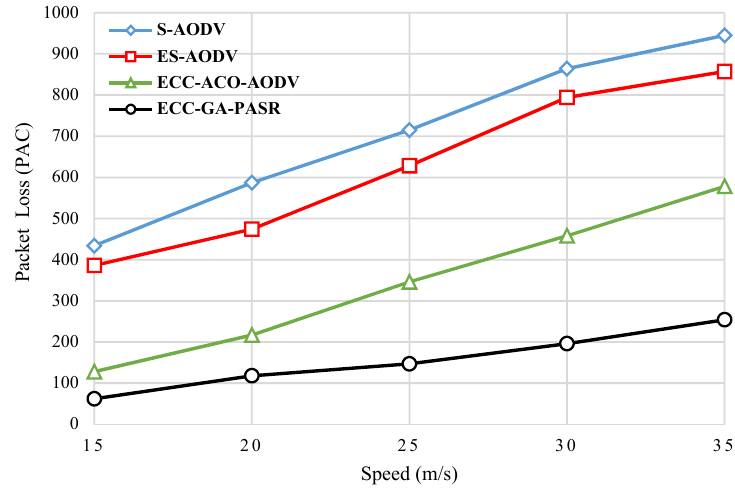
Figure 16. Packet Loss Calculation based on vary speed of vehicle.